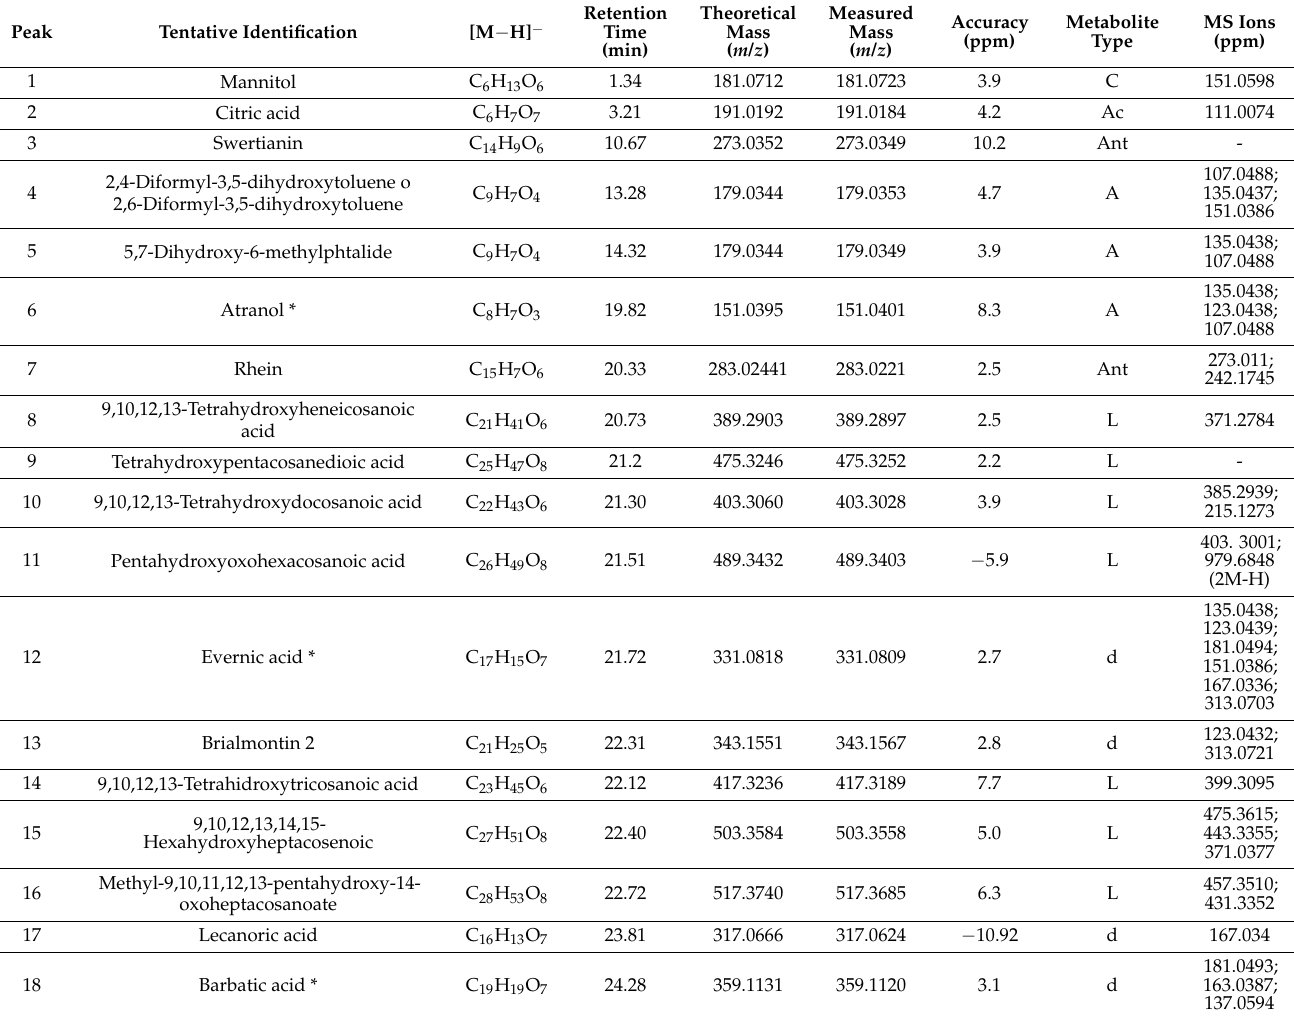
Table 1. Identification of metabolites in Lecania brialmontii by